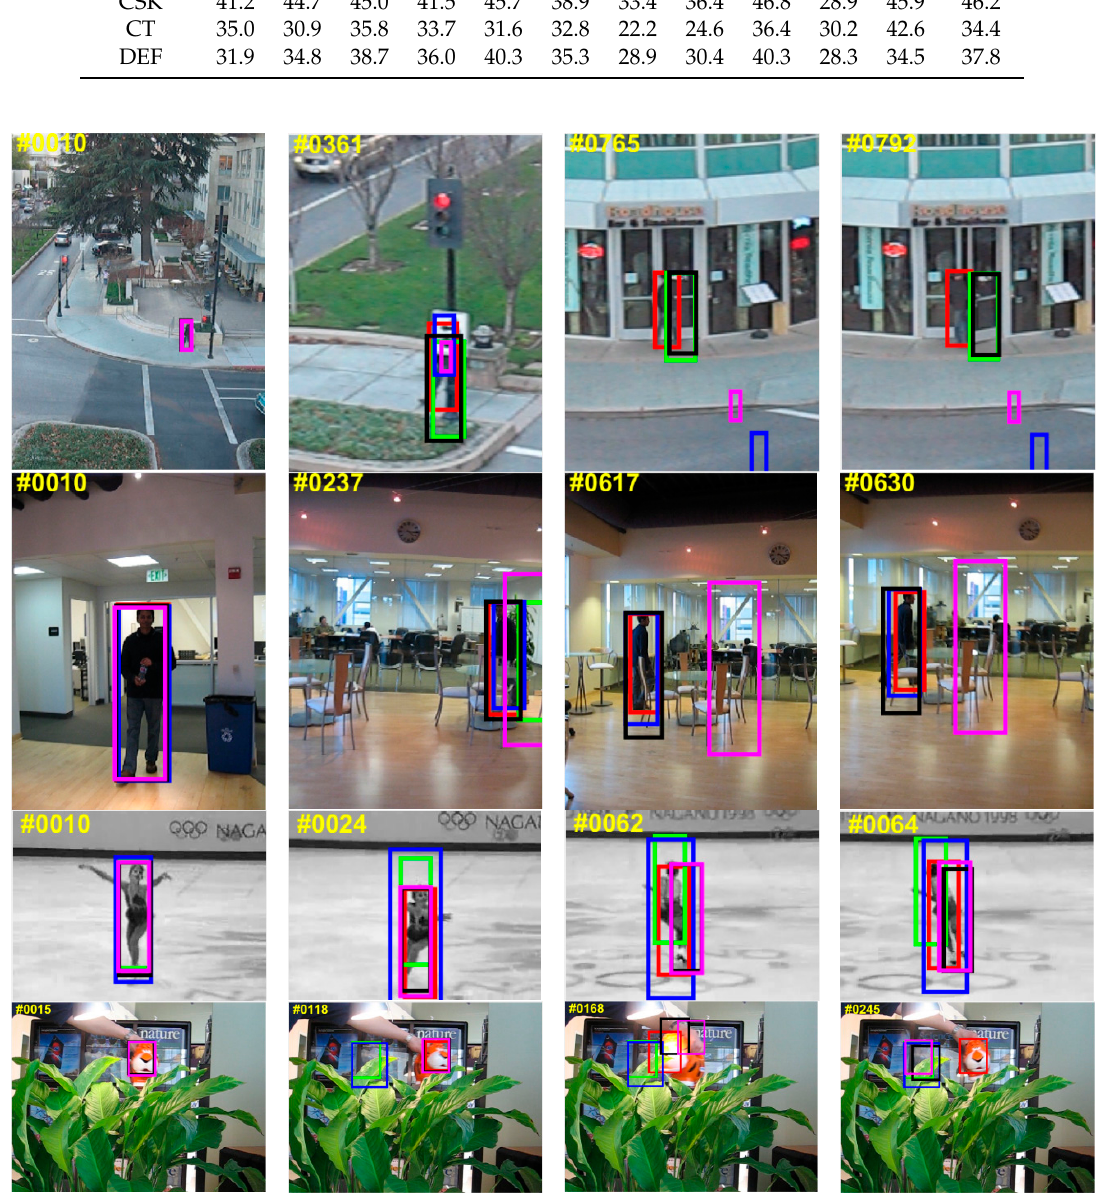
Figure 8. The representative frames from four videos successfully tracked by the MACF (in red) compared to the top 5 trackers including FDSST (in green), LCT (in blue), DSST (in black) and KCF (in purple). From top to bottom, the sequences are “Human6”, “Human2”, “Skater1” and “tiger1” on the OTB-100 benchmark.